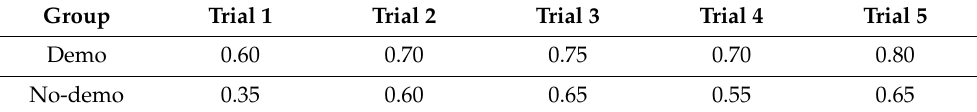
Table 1. The proportion of cats finally obtaining the reward in each trial in experiment